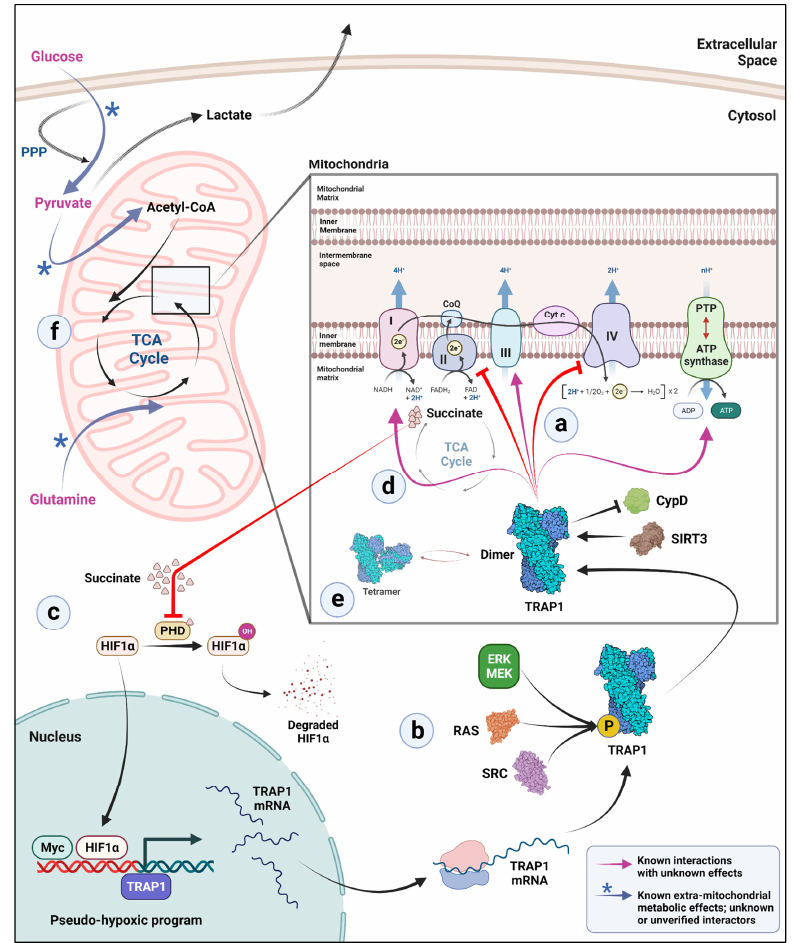
Figure 2. Potential mechanisms of TRAP1 participation in metabolic rewiring. (a) TRAP1 binds to and inhibits electron transport chain (ETC) complexes II and IV in the mitochondria. TRAP1 interacts with protein deacetylase SIRT3 in mitochondria and is reported to inhibit cyclophilin D (CypD), thereby preventing permeability transition pore (PTP) opening and inhibiting apoptosis due to cytochrome c release. (b) Further, TRAP1 activity is enhanced by phosphorylation via several pathways. Note that it remains unclear whether this happens before or after mitochondrial import of TRAP1. (c) ETC complex II inhibition by TRAP1 leads to succinate accumulation, which in turn inhibits prolyl hydroxylases in the cytosol to stabilize HIF1 α . Stabilized HIF1 α and Myc together activate a pseudo- hypoxic program, which further upregulates TRAP1 gene expression. (d) Inside mitochondria, TRAP1 also binds to ETC complexes I, III, and V (ATP synthase), but with unknown effects. (e) While TRAP1 tetramers exist alongside TRAP1 dimers in the mitochondrial matrix, determinants of the ratio of dimer to tetramer and any functional significance remain enigmatic. (f) TRAP1 presence and absence affect mitochondrial carbon preference. TRAP1 KO cells downregulate glucose- and pyruvate- derived carbon entry into the TCA cycle. A significant proportion of glucose is diverted to the pentose phosphate pathway (PPP) where it is used for the synthesis of NADPH reducing equivalents, perhaps to counter increased reactive oxygen species (ROS) that are characteristic of TRAP1 KO cells, and for the synthesis of ribose sugars. Pyruvate, upon decarboxylation, normally enters the TCA cycle and contributes to formation of acetyl-CoA, an important TCA cycle intermediate. In glycolysis, pyruvate is preferentially metabolized to lactate, generating NAD+ as a by-product of the reaction, at the expense of NADH. As with NADPH, increased levels of NADH provide more reducing equivalents to counter the increased ROS characteristic of TRAP1 KO. In contrast, TRAP1 KO cells utilize anaplerotic glutamine metabolism to maintain a functional TCA cycle by providing glutamine-derived